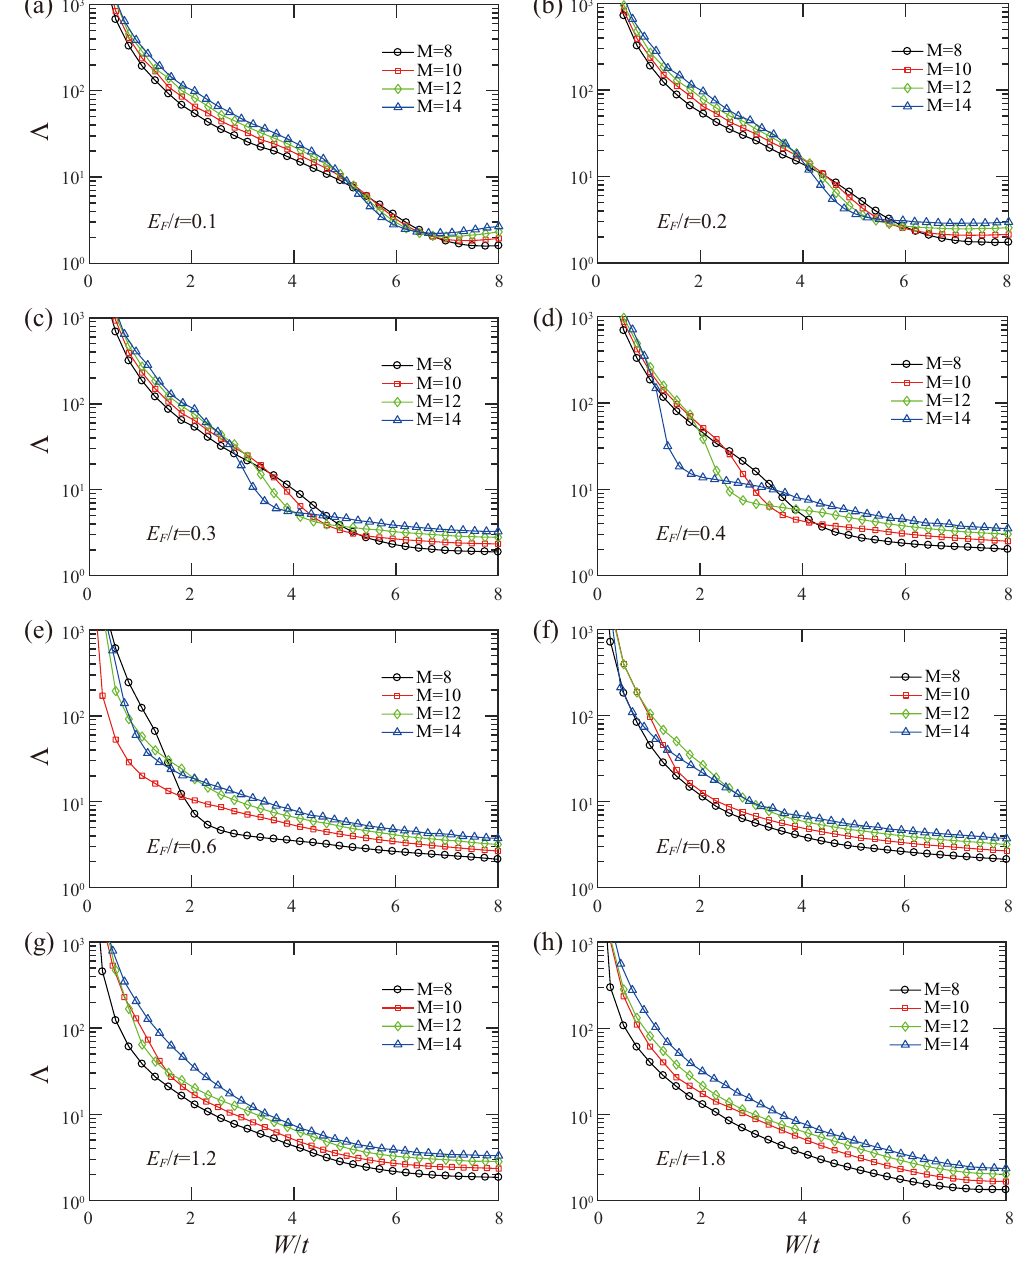
Figure 4. ( a – h ) The normalized localization length as a function of W t / for = . E t